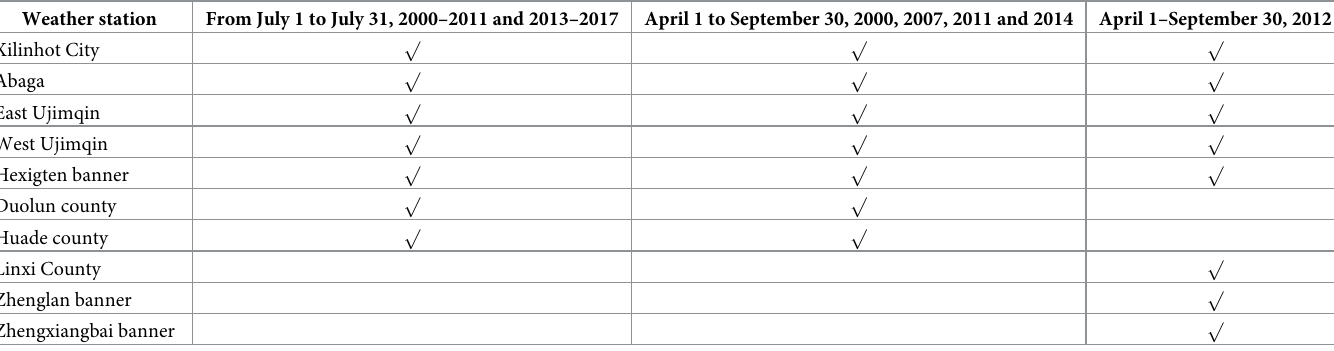
Table 1. Stations and time for meteorological